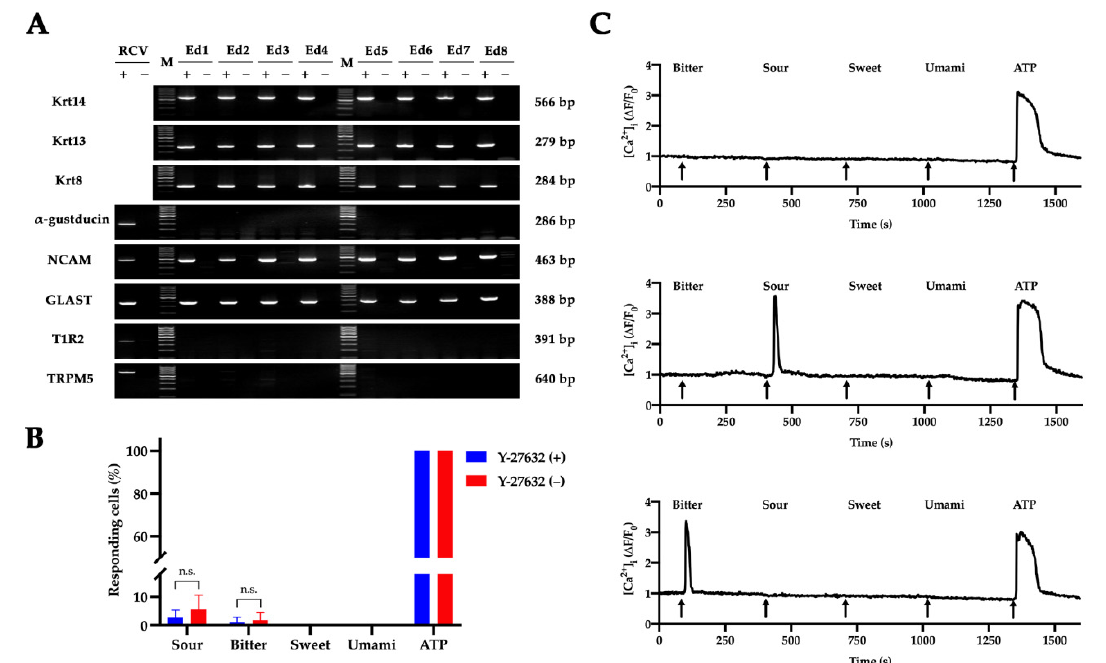
Figure 5. Characterization of cultured keratinocytes derived from non-taste lingual epithelia. ( A ) RT-PCR results showing the presence of krt 14 (basal progenitor marker), krt 13 (post-mitotic non-taste cell marker), krt 8 (pan-taste cell marker), NCAM (type III taste cell marker), and GLAST (type I taste cell marker), and absence of α -gustducin (type II taste cell marker), TRPM5 (type II taste cell marker), and T1R2 (sweet taste receptor) mRNAs in the cultured RLKs. “Ed1” to “Ed8” refer to 8 independent biological replicates of cell culture derived from non-taste dorsal lingual epithelia. “+” and “ − ” refer to PCR reactions with and without reverse transcriptase. RCV, rat circumvallate papillae tissue. M, 100 bp DNA ladders. The cells used in this experiment were continuously cultured in MTCM with Y-27632 and were harvested for PCR analysis at passage 3. ( B ) Percentage of cells responsive to taste stimuli or ATP. Cells treated with or without Y-27632 for 24–30 h were subjected to calcium imaging analyses. Only cells that responded to ATP during the last stimulation were counted ( n = 4 coverslips for each treatment; n.s. = non-significant; unpaired t -test). The total numbers of cells analyzed were 493 and 373 in the presence and absence of Y-27632, respectively. The stimuli used were: sour (10 mM citric acid), bitter (2 mM denatonium benzoate and 10 µ M cycloheximide), sweet (10 mM sucralose and 10 mM acesulfame K), umami (100 mM MSG and 1 mM IMP) and 50 µ M ATP. The cells analyzed were at passage 5. ( C ) Representative traces showing the cytosolic Ca 2+ changes of three cells that responded to ATP only ( top ), sour stimulus and ATP ( middle ), and bitter stimulus and ATP ( bottom ),